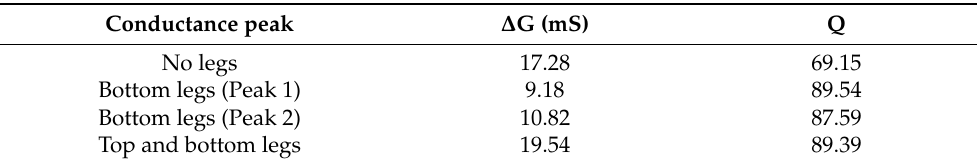
Table 2. Calculated peak conductance ( ∆ G) and quality factor (Q) of the PZT plate for different leg combinations.